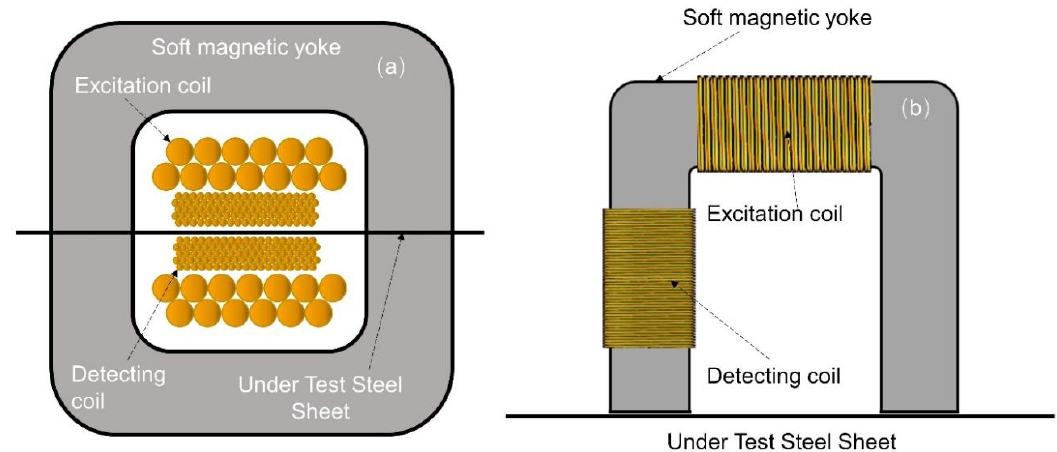
Figure 6. The permeability measurement set-ups: ( a ) the primary permeability tester based on the single sheet standard method; ( b ) the secondary standard based on a yoke arrangement magnetizing the surface of the under-test steel.